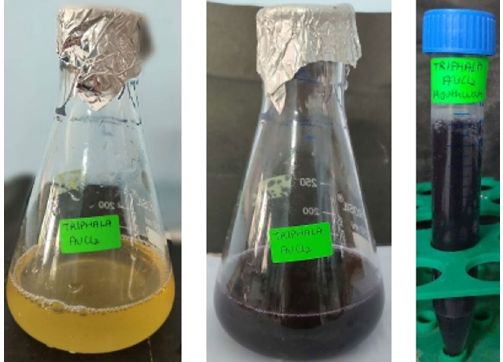
Fig. 1. Triphala plant mediated AuNP’s and its based mouthwash. It represents color change from pale yellow to violet indicating formation of Gold nanoparticles from which the mouthwash is prepared.